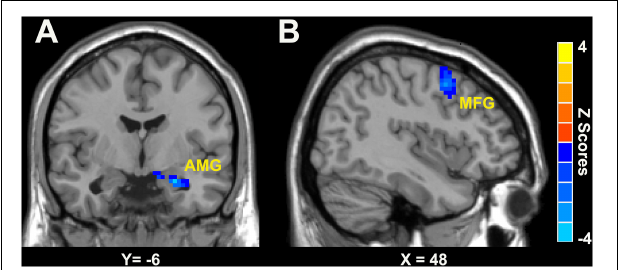
TABLE 2 | Group differences in bilateral LC-NE FC network.